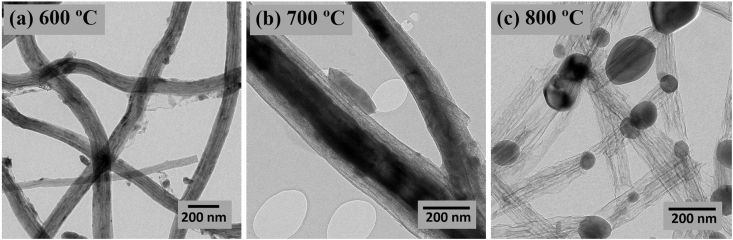
TEM images of electrospun LiFePO4 composites obtained at various heat-treatment temperatures of (a) 600 ᵒC, (b) 700 ᵒC, and (c) 800 ᵒC.